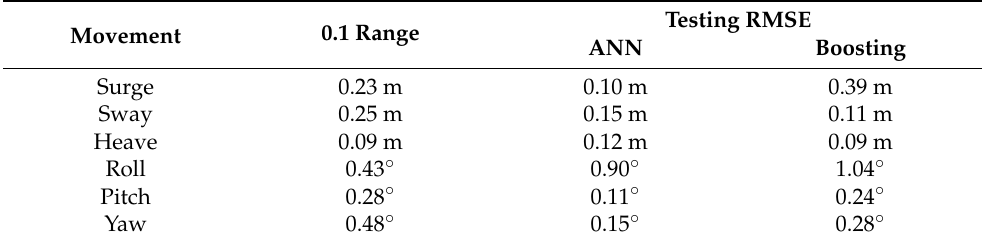
Table 5. Testing errors for each artificial neural networks and gradient boosting ship movement models.